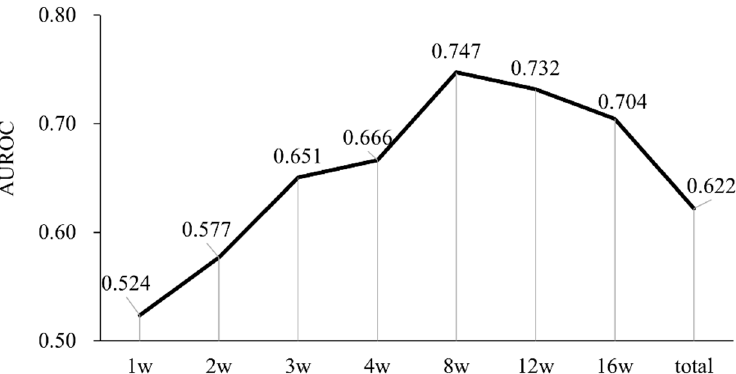
Figure 5. Discrimination ability of relative dose intensity for radiological response by the area under the receiver operating curve. Plot of the area under the receiver operator curve (AUROC) identifying radiological response by RDI for each week. Maximum AUROC was 0.747 at 8 weeks.